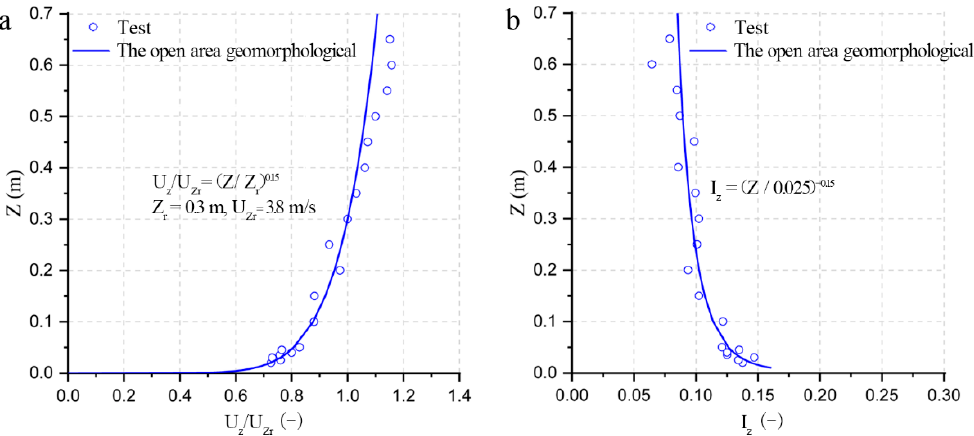
Figure 5. ( a ) Vertical profile of the mean velocity. ( b ) Vertical profile of the turbulence intensity in the simulated boundary layer.